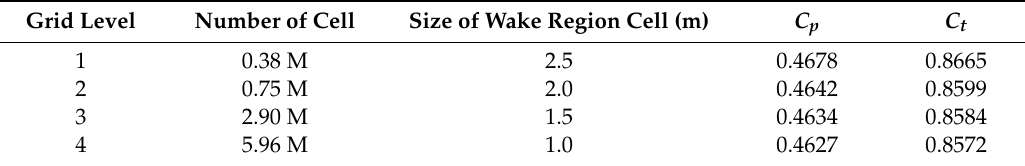
Table 2. Mesh independence test of power and thrust coe ffi